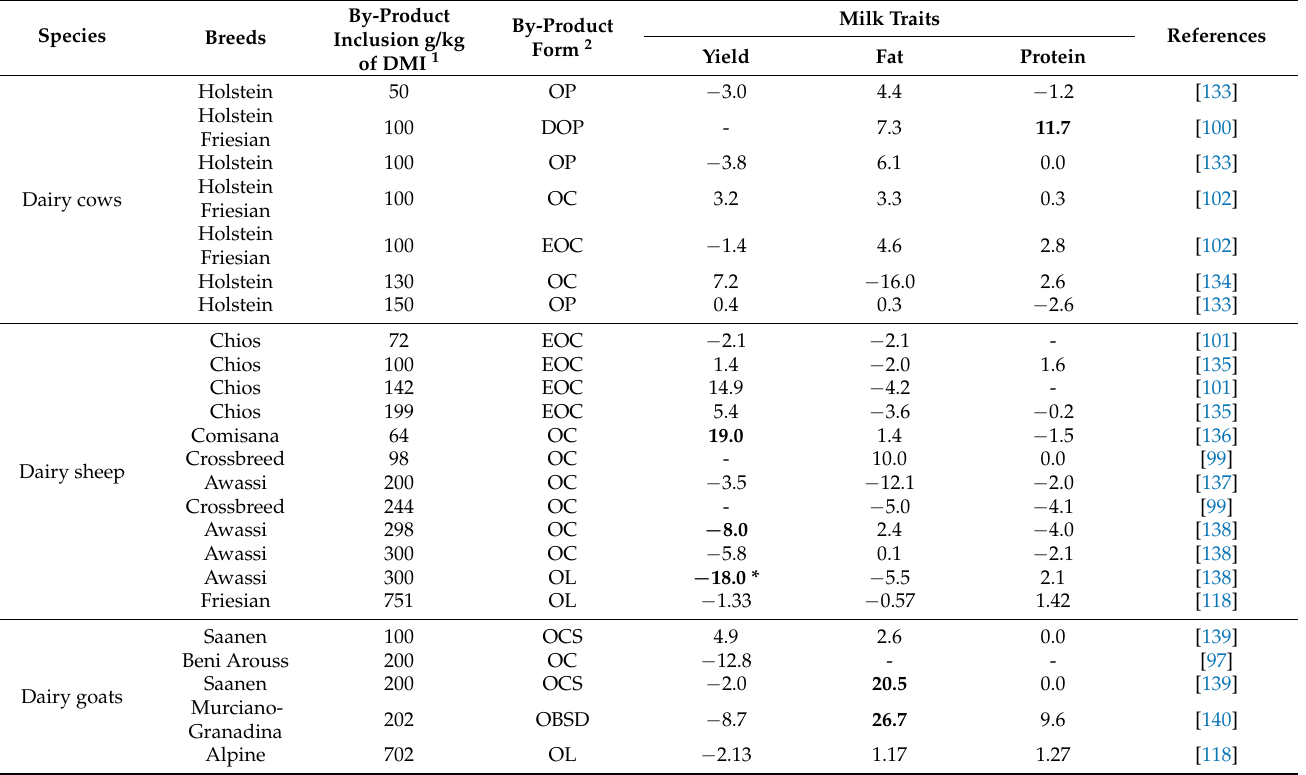
Table 6. Effect of olive by-products included in dairy ruminants’ diets on milk yield, fat%, protein%, and the fat-to-protein ratio. Data are reported as the proportional difference between the treatment group, at the respective level of inclusion, and the control